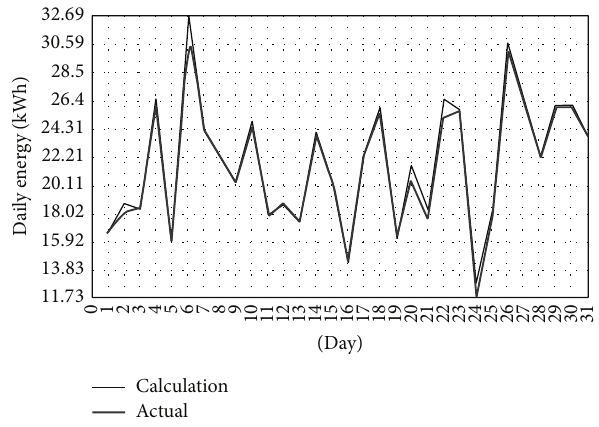
Figure 16: Daily energy output from polycrystalline PV module. Reference